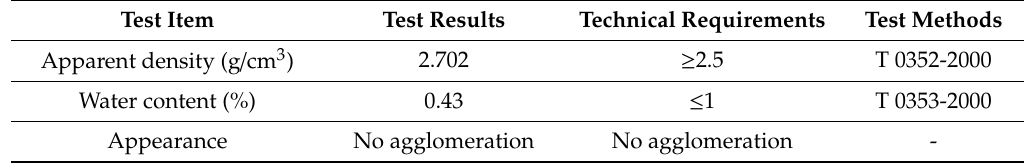
Table 3. Properties of limestone mineral